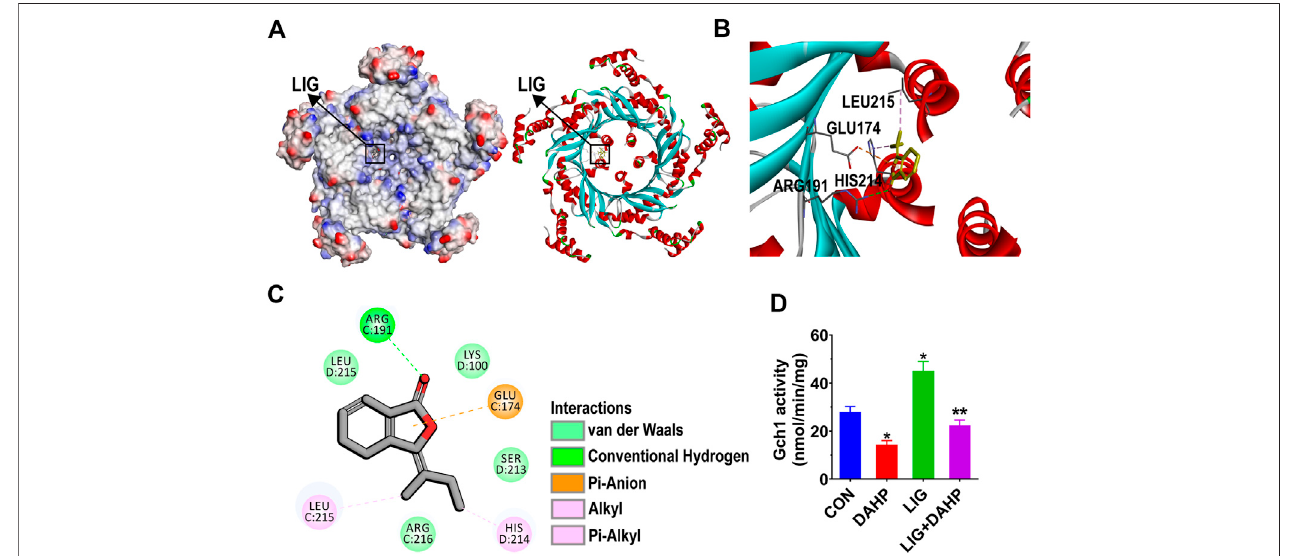
FIGURE 6 | Structural interactions of LIG with Gch1 and their effects on activity. (A) Surface of Gch1 colored by ionizability. The black rectangle marks LIG. (B) Structural representation of LIG binding to Gch1 (PDB: 1WUR) as inferred from docking simulations. LIG is shown as yellow sticks. (C) 2D diagram of the interaction between LIG and Gch1 showing the major binding sites and bonding forces. (D) Gch1 activity quanti fi ed by fl uorescence detection. The fused or free Gch1 protein was incubated in the dark with GTP assay buffer (310 μ M). DAHP was added at a concentration of 1 mM. Data are the mean ± SEM, n (cid:1) 6. * p < 0.05, signi fi cantly different from the CON group, ** p < 0.05, signi fi cantly different from the LIG group.